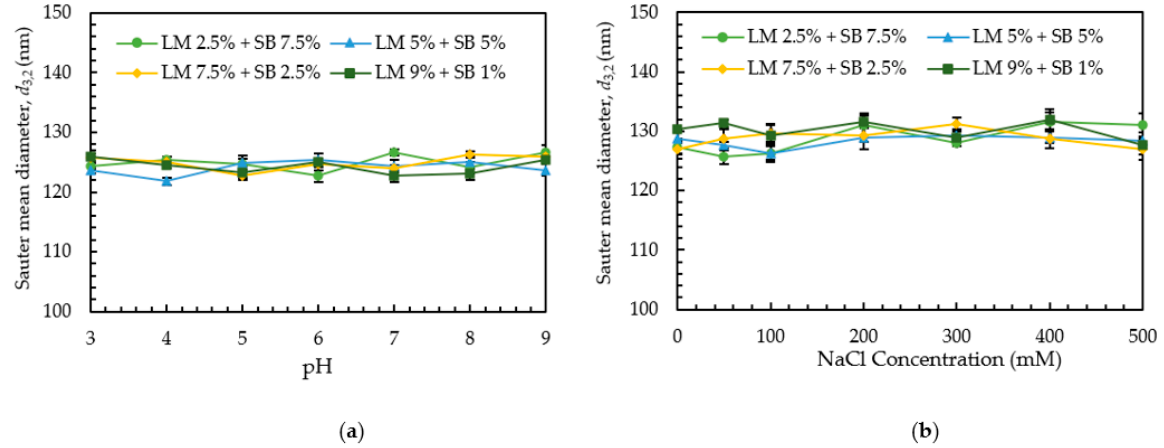
Figure 2. ( a ) E ff ect of pH and ( b ) NaCl on the Sauter mean diameter ( d 3,2